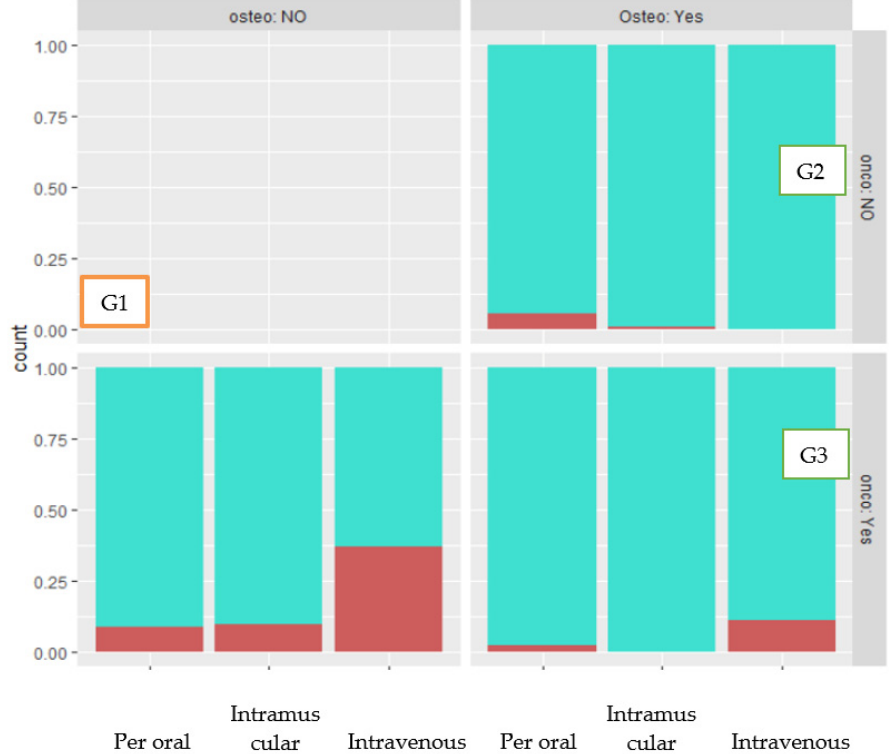
Figure 6. Relative incidence of MRONJ in G1, G2, and G3 by route of administration